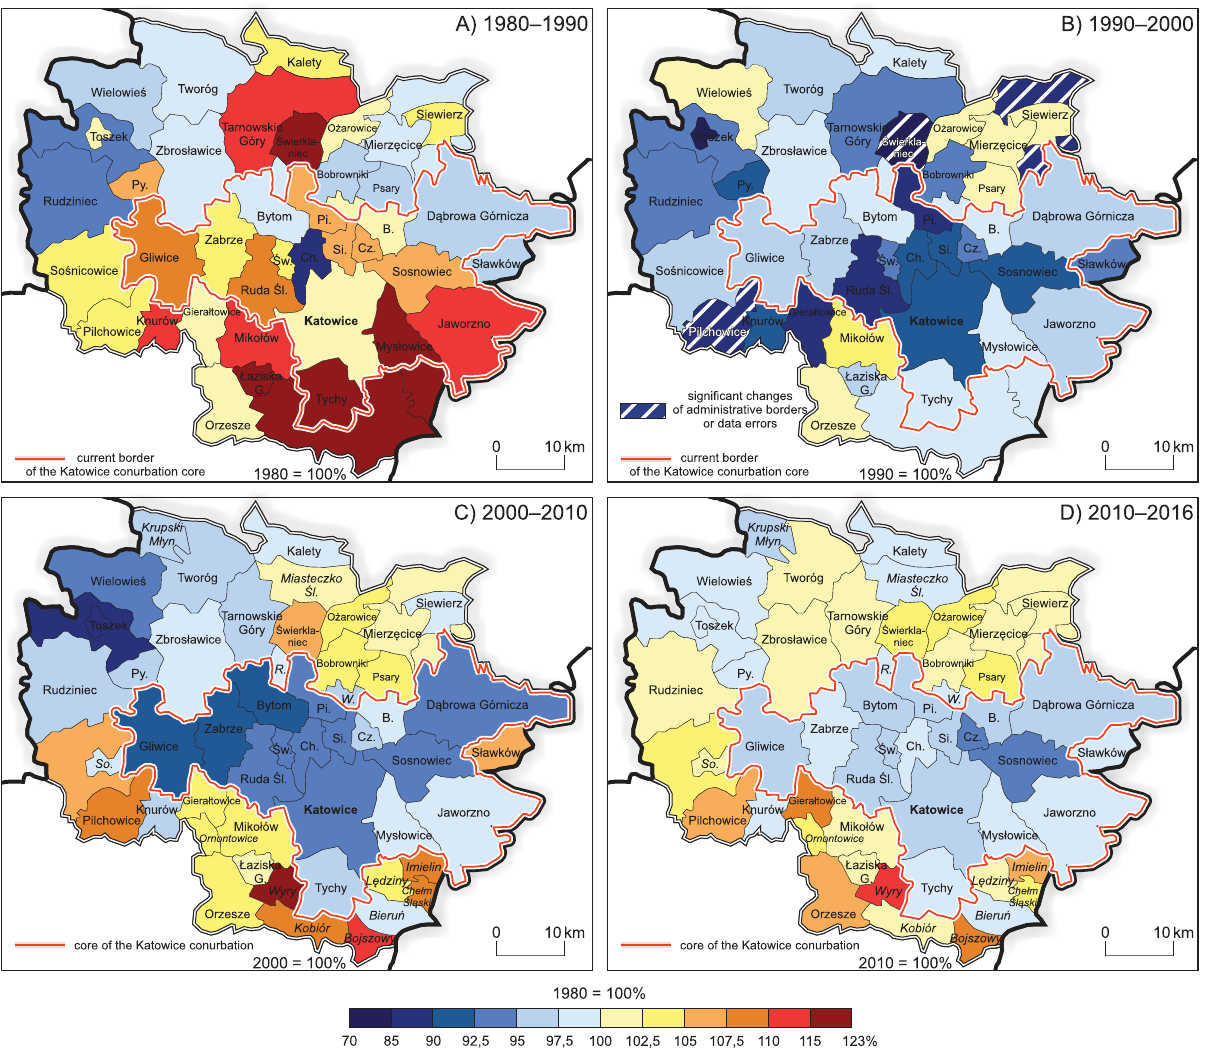
Fig. 5. The dynamics of population changes in the commune of the Katowice conurbation in the period 1980–2016 (Source: own elaboration based on Local Data Bank of the Central Statistical Office; Rocznik Statystyczny Województwa Katowickiego 1981,–1995, WUS,